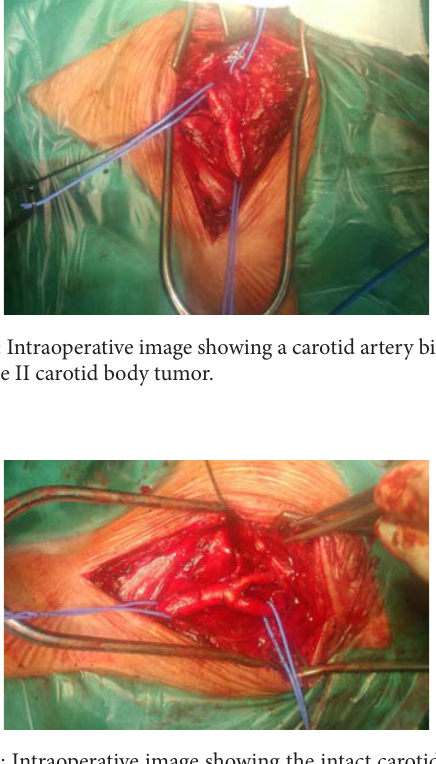
Figure 2: Intraoperative image showing the intact carotid bifurca- tion after the excision of a carotid body